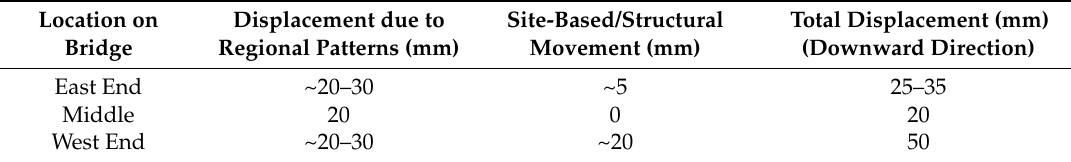
Figure 7. Total displacement across the area of high displacement velocity in Oxnard, California. Plot displays the trend of total displacement values from the west to the east of the high displacement zone in Oxnard, California. This longitudinal axis is based on GPS location. Total displacement average and standard deviation are indicated in the top left corner. Table 1. Distinguishing between regional and site-based/structural displacement along the Santa Clara River